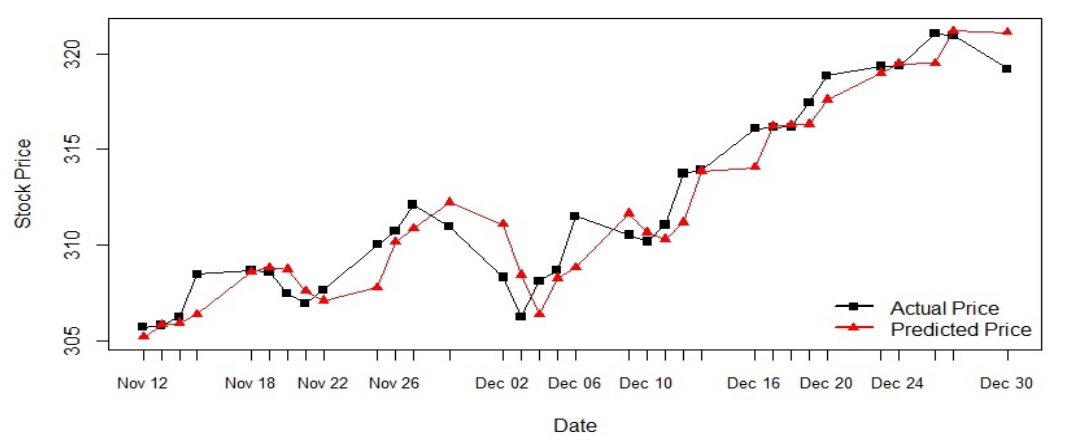
Figure 6. ARIMA (0,2,1) model prediction.